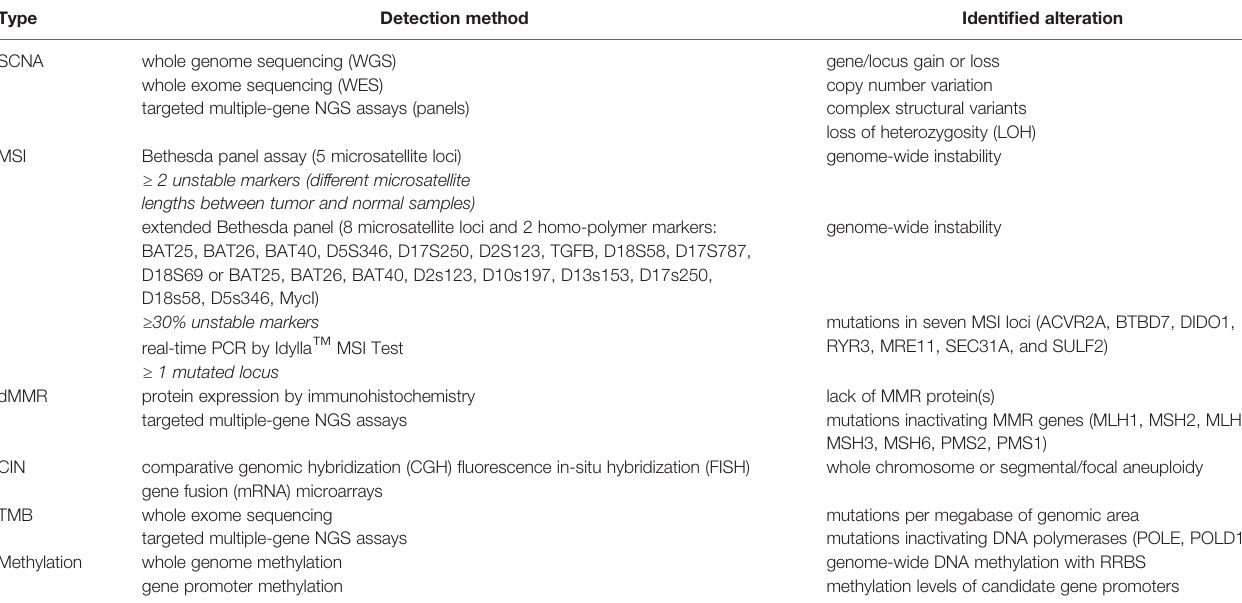
TABLE 2 | Molecular alterations underlying genetic instability useful in cancer patients ’ strati fi cation for